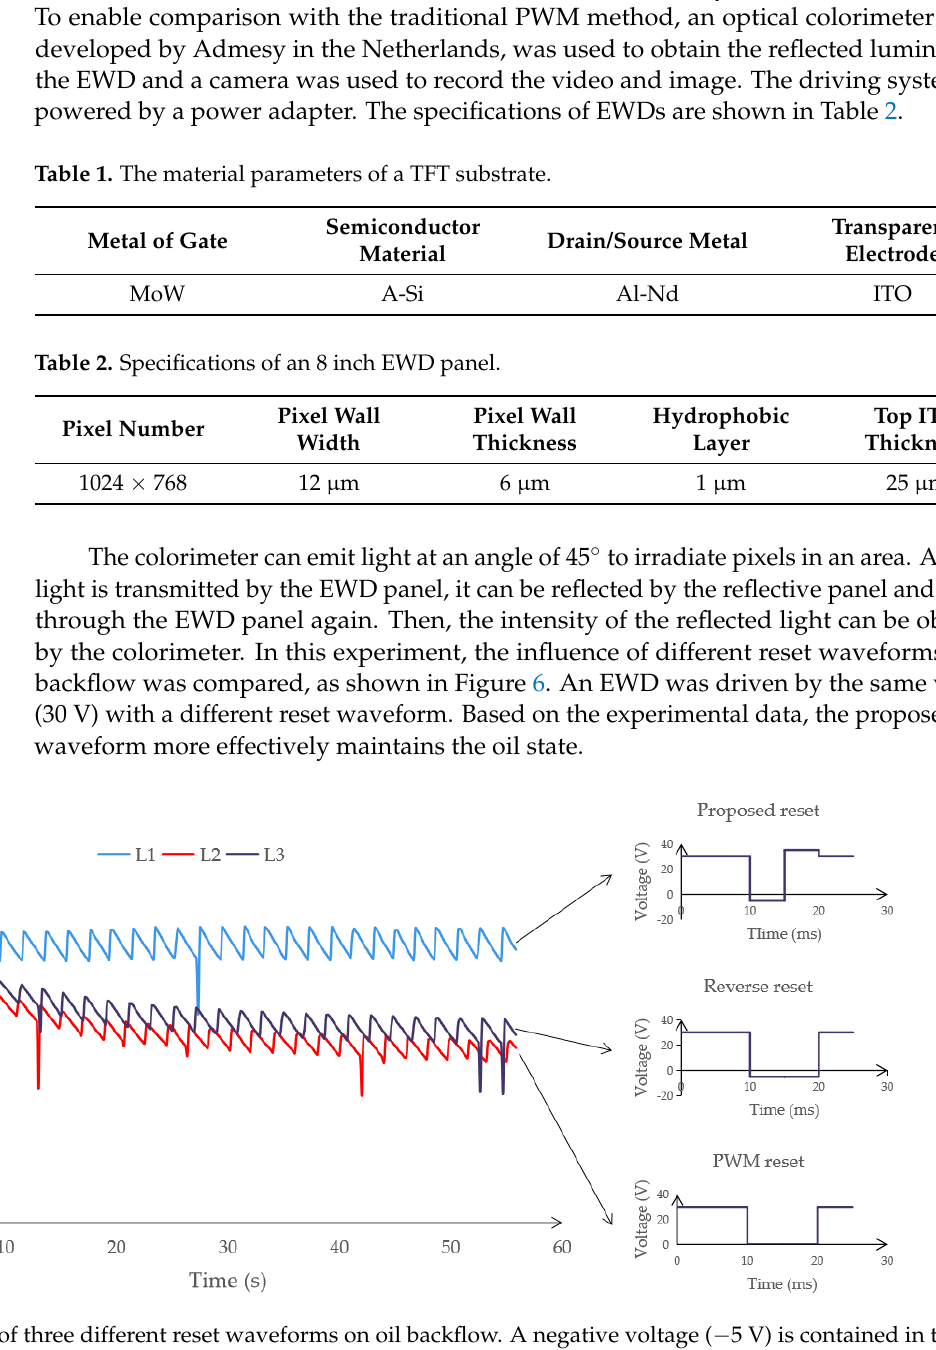
Figure 7. Grayscales affected by oil backflow. The luminance of four grayscales decreased after 30 s. After 30 s, the luminance of G3 ′ was the same as G4 ′ . The initial luminance of grayscales was G1 ′ , G2 ′ , G3 ′ , and G4 ′ . After 30 s, the grayscales without the reset waveform ere changed to G1, G2, and G3, and grayscales with the reset waveform changed to G1r, G2r, G3r, and G4r.